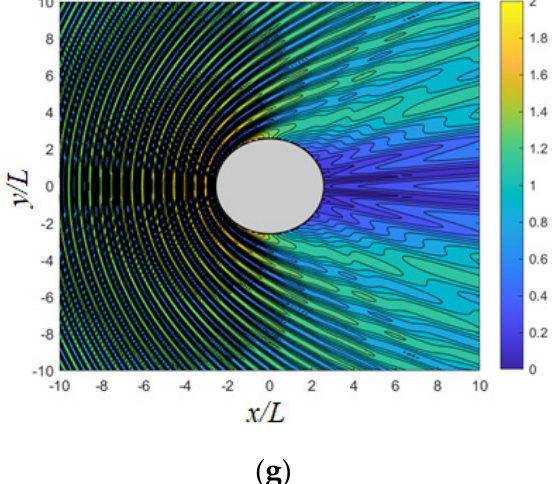
Figure 8. Wave fields for triangular, square, hexagonal, and circular platforms ( T = 5 s): ( a ) triangular platform (Case 1); ( b ) triangular platform (Case 2); ( c ) square platform (Case 1); ( d ) square platform (Case 2); ( e ) hexagonal platform (Case 1); ( f ) hexagonal platform (Case 2); and ( g ) circular platform.